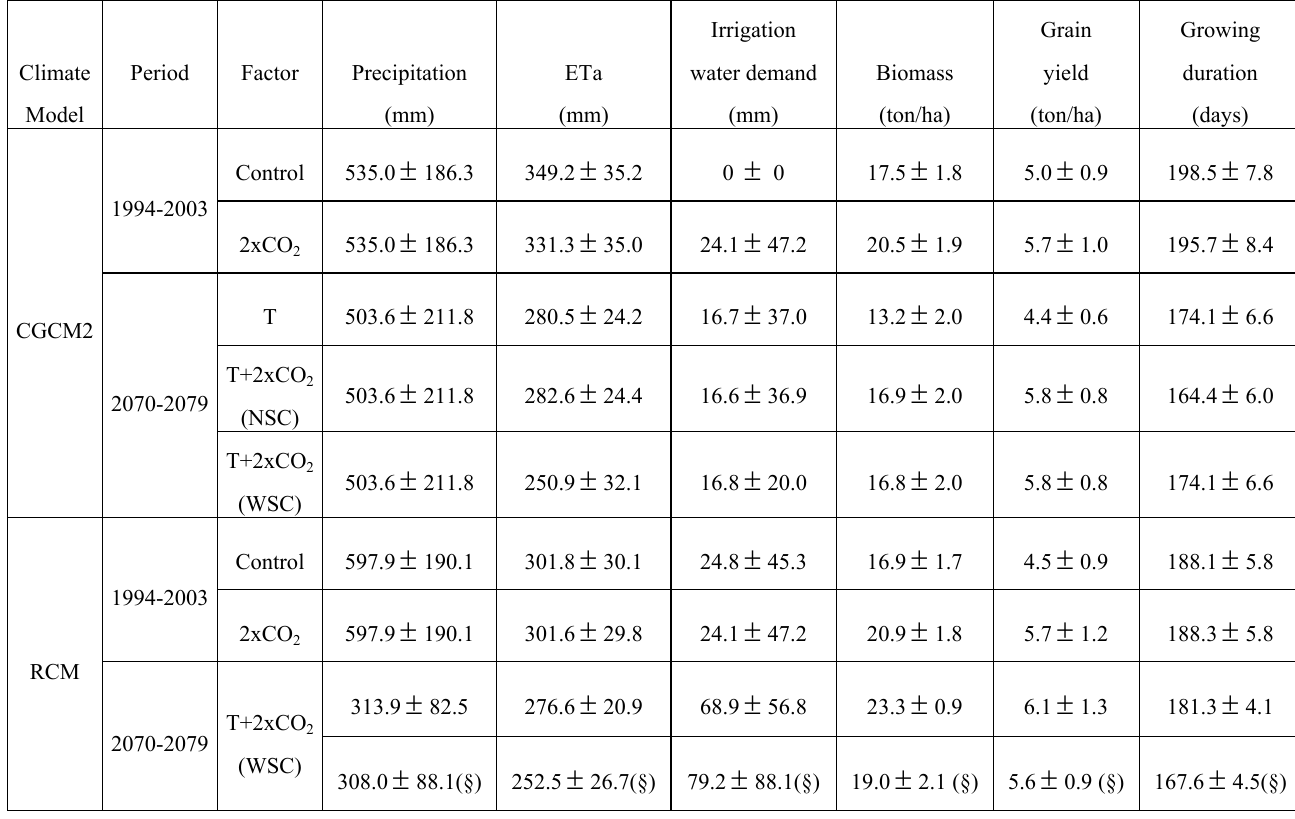
) on water balance and crop growth for 2